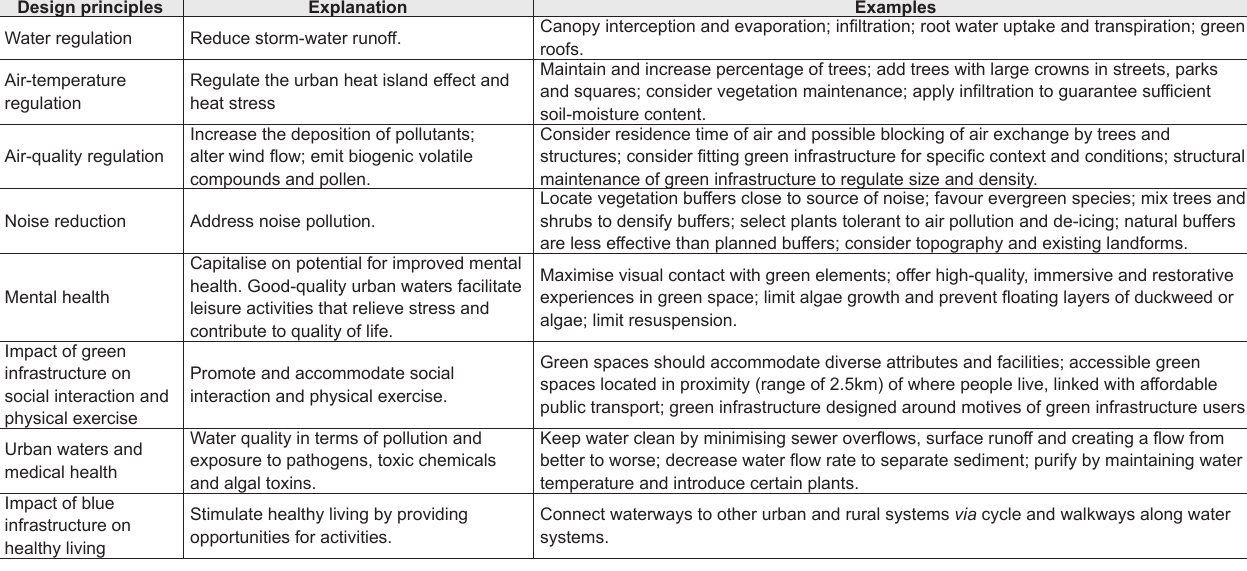
Design principles for climate adaptation from The Netherlands Design